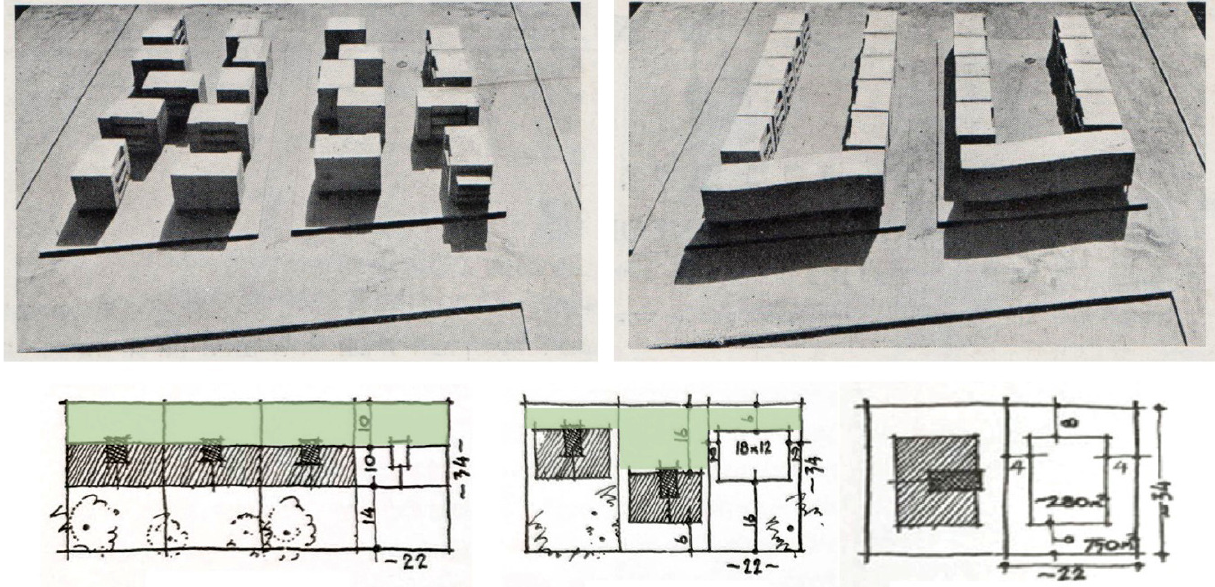
Figure 4. Top: Arieh Sharon’s proposal for the extra‐large house (right) vs. Tel Aviv’s common urban housing blocks (left). Bottom: Dov Karmi’s critique of the Tel Avivian house plot (right) by offering two alternative rearrangements of housing parcels in a “chess form” (middle) and a “continuous form” (left). Both alternative rearrangements, providing wider green spaces around apartment buildings, appear later in Be’eri’s estate layout. Sources: A. Sharon (1937, p. 2; top) and D. Karmi (1946, p. 3;